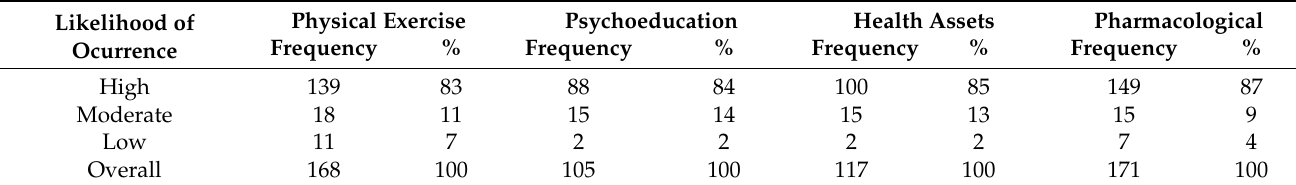
Table 2. Frequencies of expert patient opinions on the final questionnaire.